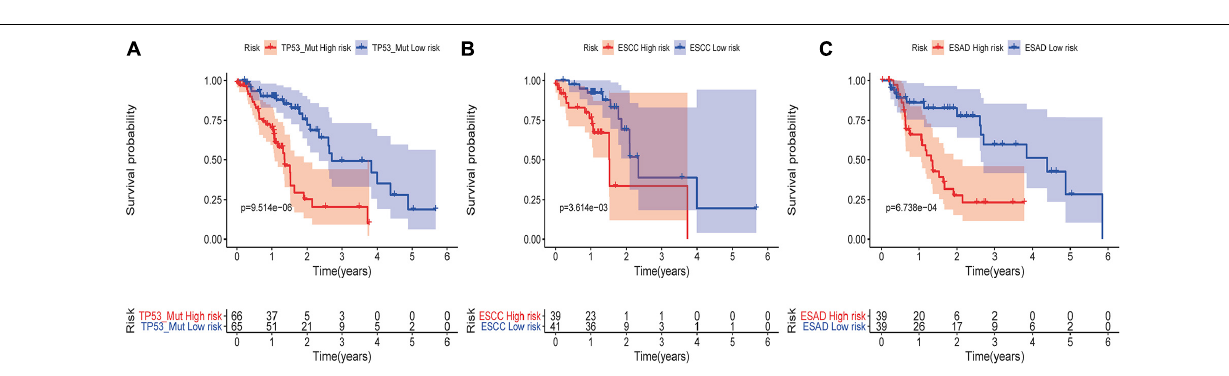
FIGURE 6 | Kaplan-Meier analysis of overall survival in ESCA patients according to the risk model. Kaplan-Meier analysis of the TP53 mutation subgroup (A) ; the ESCC subgroup (B) ; and the ESAD subgroup (C)